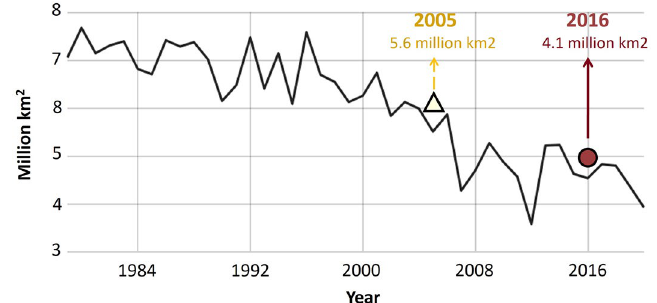
Figure 2. Arctic average September minimum sea ice extent (modified from NASA Global Climate Change, NSIDC/NASA, clima te. nasa. gov). Sampling years are indicated by a white triangle (2005) and red circle (2016), numbers above the triangle and circle indicate mean sea ice extent in 2005 (in yellow) and 2016 (in red).